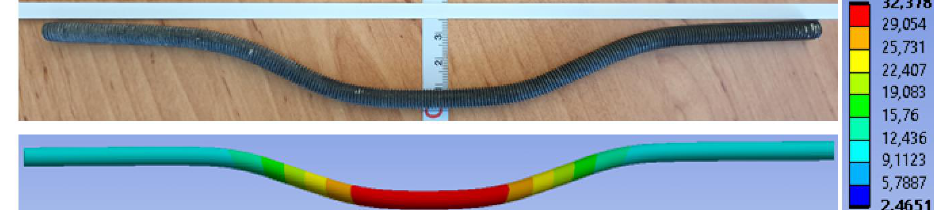
Figure 19. Deformation of a dowel (mm).